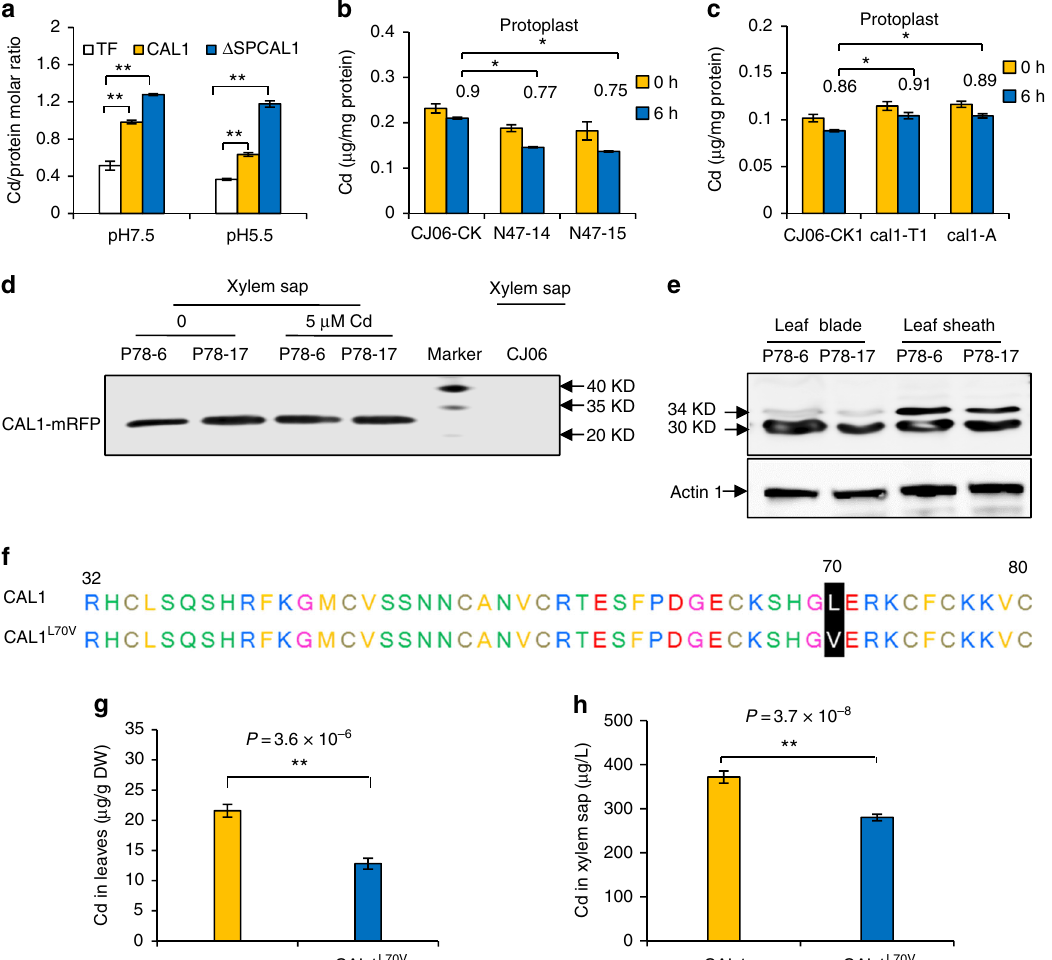
Fig. 4 Functional characterization of CAL1. a In vitro Cd binding assay. Full length CAL1 and the secretion signal peptide (SP)-deleted CAL1 ( Δ SPCAL1) were used. Different form of CAL1 recombinant proteins were extracted from BL-21, and then incubated with 100 µ M Cd for 1 h, pH = 7.5 or 5.5. TF represents the E. coli trigger factor protein that fused to the N-terminus of target proteins. b , c Cd contents in protoplasts. Rice seedlings of the complementation lines ( b ) or functional disrupted mutants ( c ) were grown for 14 days in hydroponics supplemented with 5 µ M Cd, and leaf sheath was sampled to isolate protoplasts, which were then cultivated in W5 buffer for indicated time before determination of Cd contents. The numbers above each bar represent the 6/0 h Cd ratios in protoplasts, and signi fi cant difference between them was determined by Student ’ s t -test (* P < 0.05). Data are mean ± SD, n = 3. d , e Detection of CAL1 by using an anti-RFP antibody in transgenic plants P78 harboring the construct proCAL1 TN1 :: CAL1-mRFP . Rice seedlings were grown for 21 days in hydroponics supplemented with 0 or 5 µ M Cd. Proteins extracted from xylem sap ( d ) or leaf and stem tissues ( e ) were subjected to Western gel blotting assay. The wild-type CJ06 was used as a negative control. Actin was used as the loading control. f Two types of CAL1 proteins derived from natural variations in different rice varieties. g , h Cd contents in leaf ( g ) or xylem sap ( h ) of rice varieties harboring either CAL1 ( n = 100) or CAL1L70V ( n = 7). Two-weeks-old seedlings grown in hydroponics were exposed to 10 µ M Cd for 7 days, and then subjected to sampling and determination of Cd contents. Data are mean ± SE. Signi fi cant differences were determined by Student ’ s t -test (* P < 0.05, ** P <